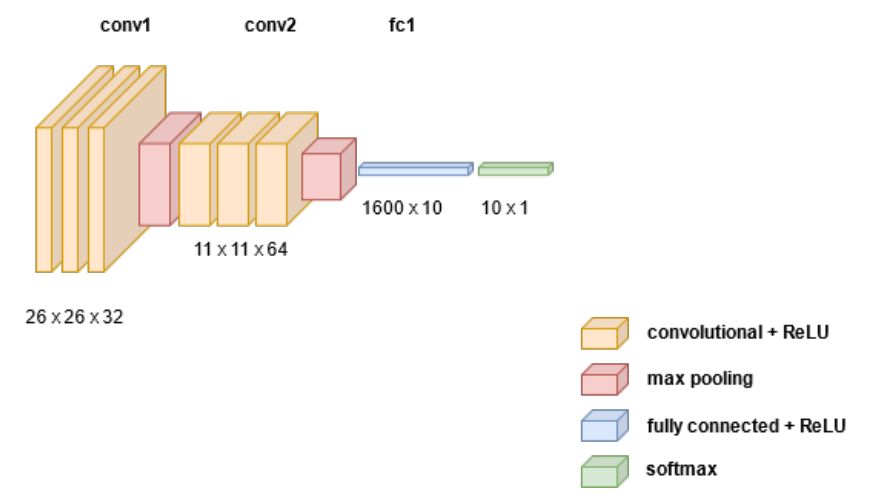
Figure 3. Structure of CNN used, showing the results of all